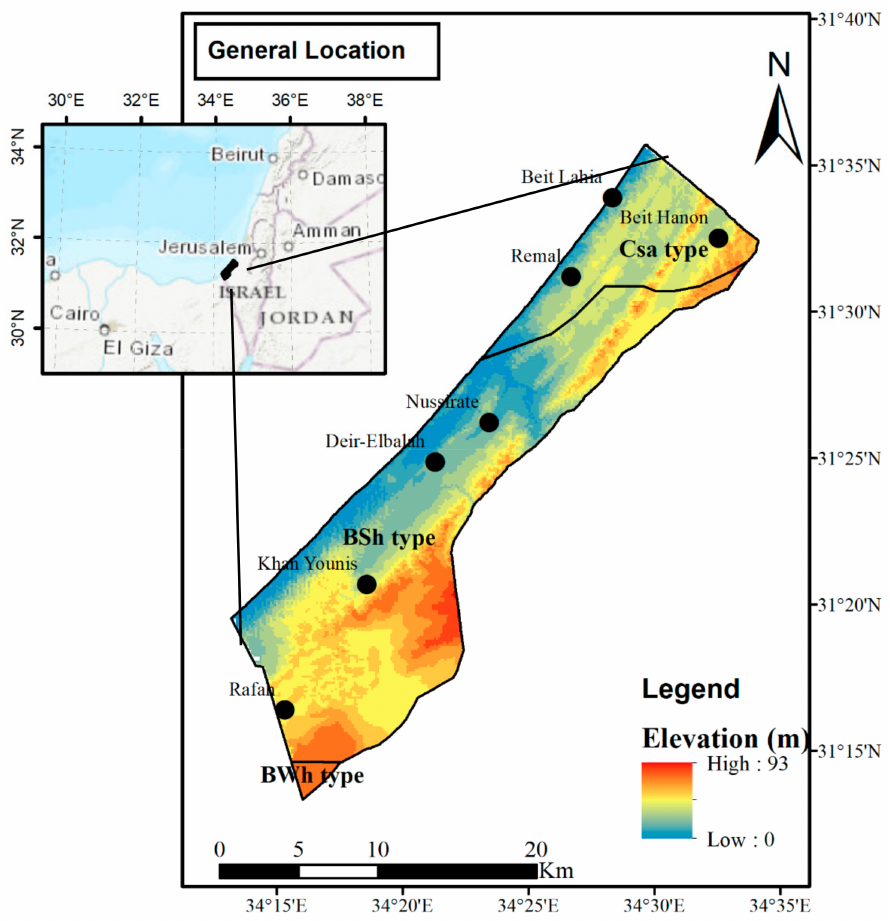
Figure 1. Location map of Gaza, climate classes according to Köppen-Geiger climate classification and meteorological